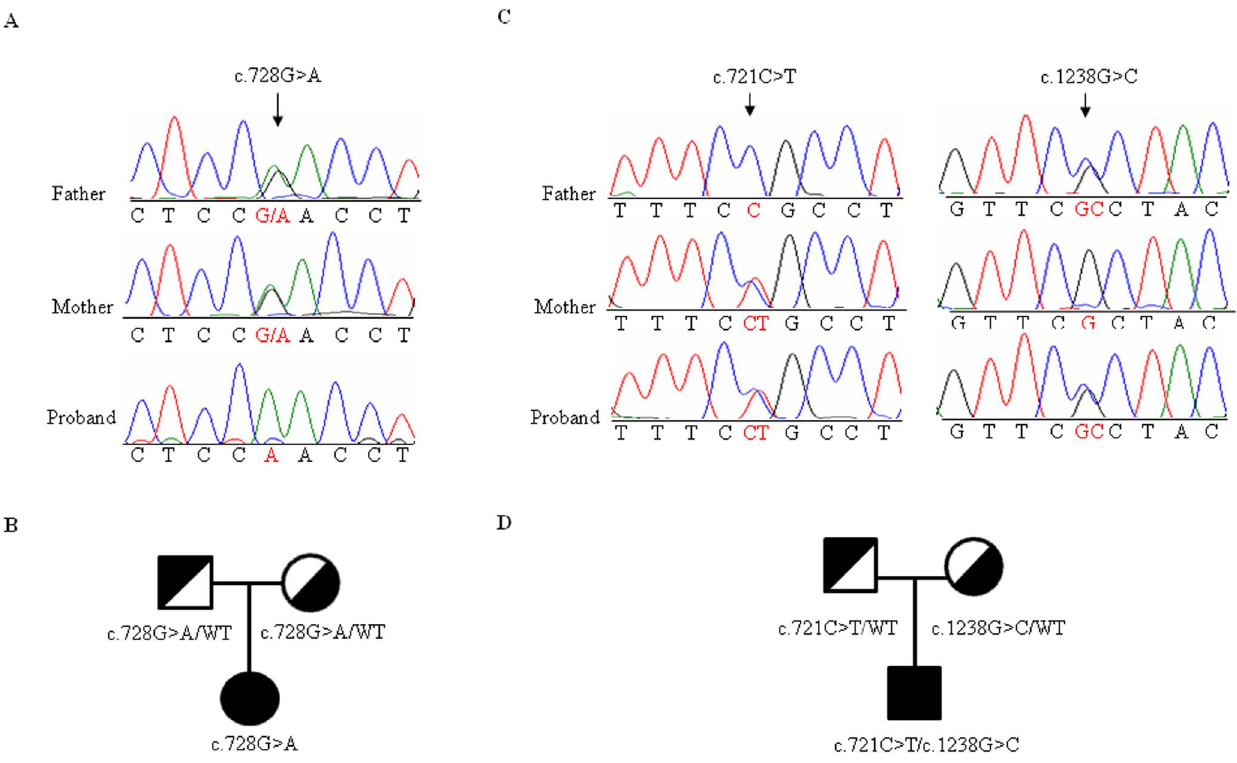
Figure 5. The representative mutation types observed based on the genetic principles of autosomal recessive inheritance. (A) A homozygous missense mutation of G to A in exon 7 of the PAH gene. The parents of this patient were confirmed to be heterozygous carriers for this mutation. (B) The family pedigree of the patient described in panel A. (C) A heterozygous missense mutation of T to A in exon 7 and a heterozygous mutation of G to A in exon 12 of the PAH gene. The father of this patient was a heterozygous carrier with a C allele in exon 12, while the mother was a heterozygous carrier with a T allele in exon 7. (D) The family pedigree of the patient described in panel C.